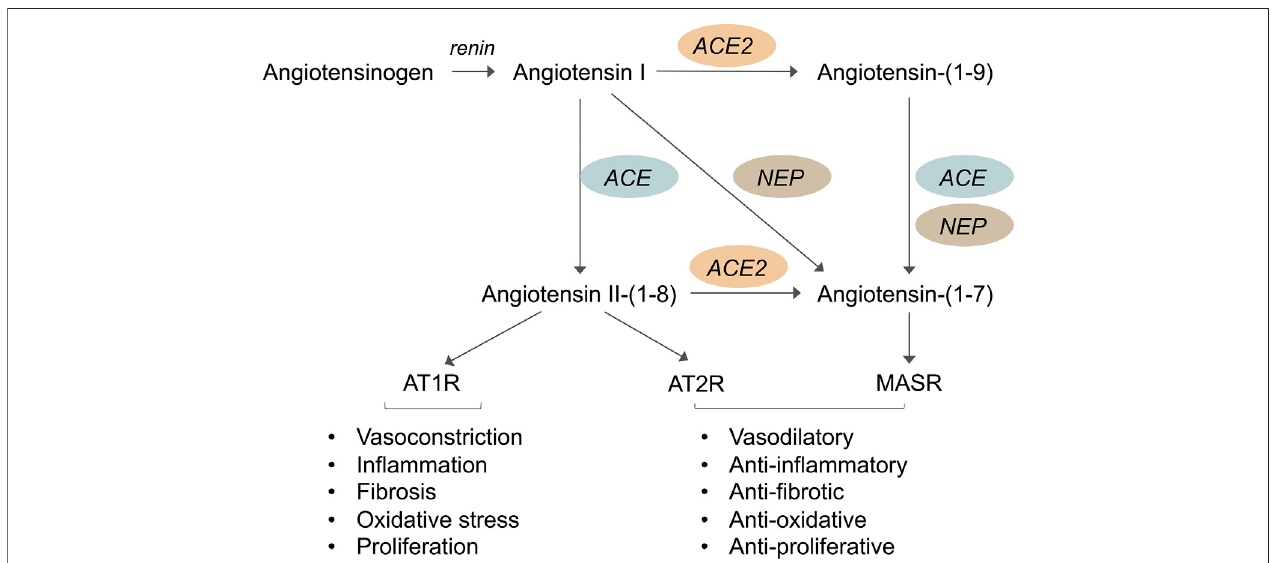
FIGURE 1 | Schematic representation of the renin-angiotensin system (RAS) showing that the angiotensin converting enzyme 2 (ACE2)/Angiotensin-(1 – 7)/Mas receptoraxisexertsoppositeeffectstothoseofACE/AngiotensinII/AT1receptoraxis.RenincleaveshepaticangiotensinogenintoAngiotensinIwhichisthencleavedvia ACE into Angiotensin II. The effectsofAngiotensin II are exerted mainly through the activation of the Angiotensin IItype 1 receptor (AT1R) and includes vasoconstriction, in fl ammation, fi brosis,oxidativestressandcellgrowth.AngiotensinIIalsobindstoAngiotensinIItype2receptor(AT2R)whichusuallyopposestheactionsofAT1R. Angiotensin-(1 – 7), which is a speci fi c Mas receptor (MasR) agonist, can be formed directly from Angiotensin II via ACE2, or it can be generated through the ACE2- catalyzed hydrolysis of Angiotensin I to the inactive Angiotensin-(1 – 9) which is then converted to Angiotensin-(1 – 7) by ACE or neprilysin (NEP). However, Angiotensin- (1 – 7)is mainly formed throughthe action ofACE2 onAngiotensinII which hasmore af fi nity toACE2 than Angiotensin I.When levels ofAng IIare not suf fi ciently elevated, Ang-(1 – 7)canalsobeformeddirectlyfromAngIviaNEP.InteractionofAngiotensin-(1 – 7)withMasRtriggersintracellularsignalingpathwaysleadingtobene fi cialactions such as vasodilation, anti-in fl ammatory, anti- fi brotic and anti-oxidative effects, and inhibition of cell proliferation.